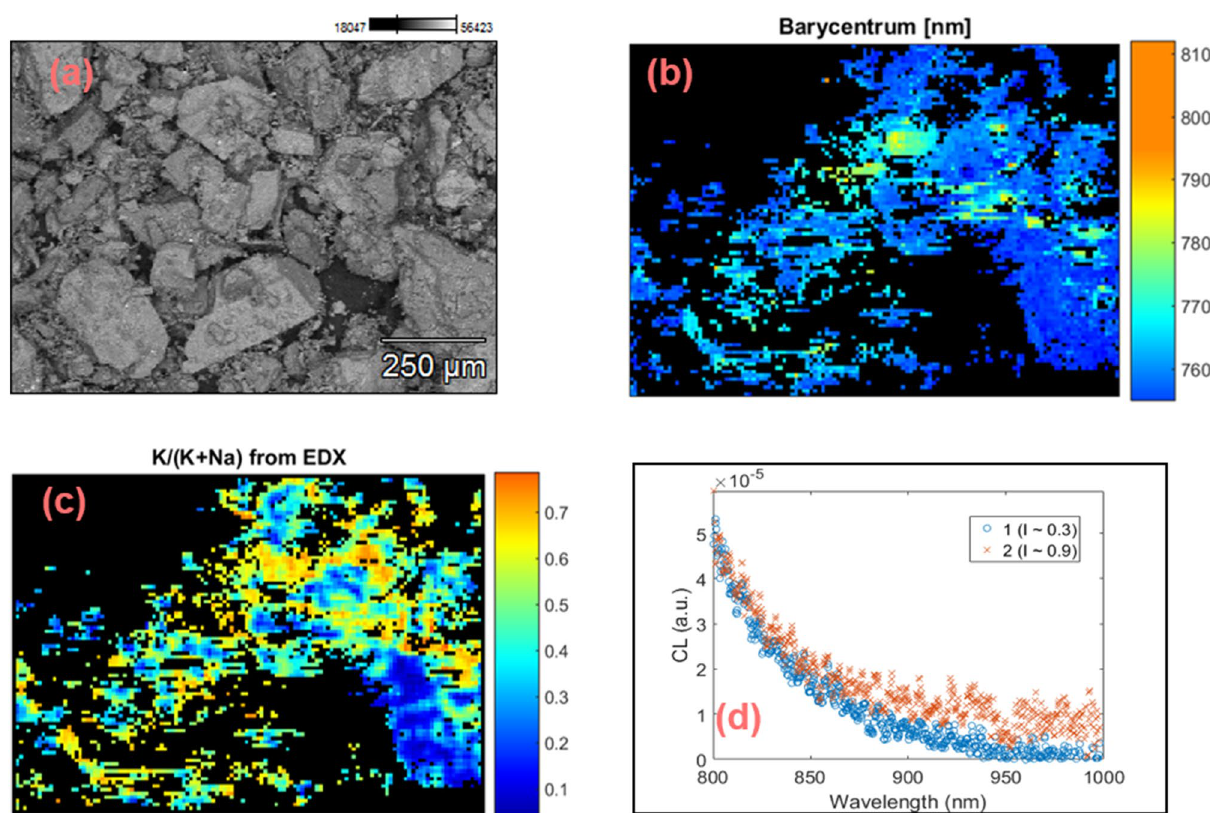
Figure 6. CL and elemental data (CL-EDX) for sample K7. ( a ) BSE image, ( b ) barycenter map in the range 755–812 nm, ( c ) relative concentration map of the K-content (K/K + Na), and ( d ) local CL spectra of two regions at normalized intensities, I ≈0.9 I max and ≈0.3 I max on the intensity map (not shown). These images were generated using Matlab (Version: R2016, Url: https ://www.mathw orks.com/produ cts/matla